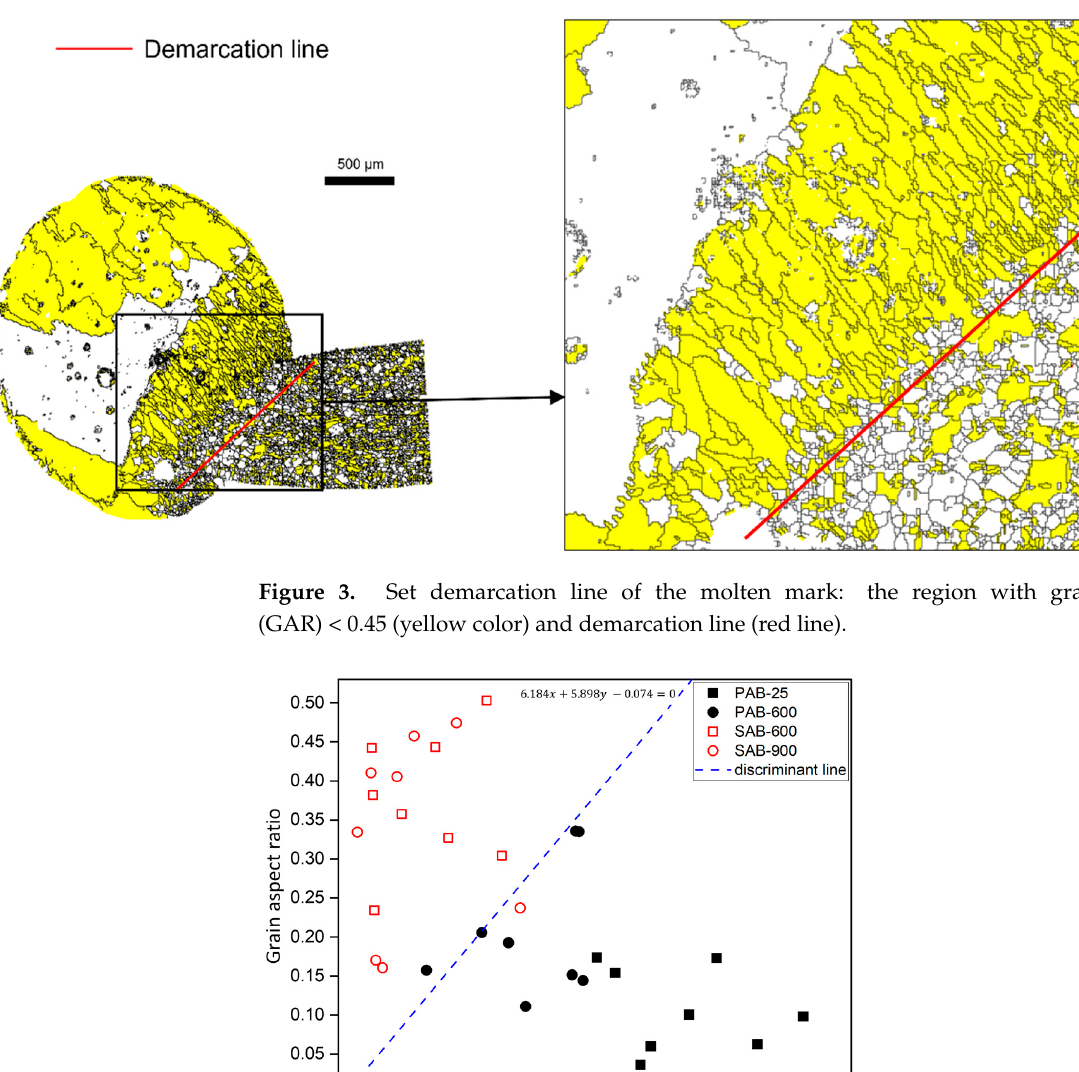
Figure 2. Changes in columnar-structure region (yellow color) according to grain aspect ratio (GAR) values. Red dotted line is the arbitrary demarcation line. ( a ) 0 < GAR < 0.35, ( b ) 0 < GAR < 0.45, ( c ) 0 < GAR < 0.55.